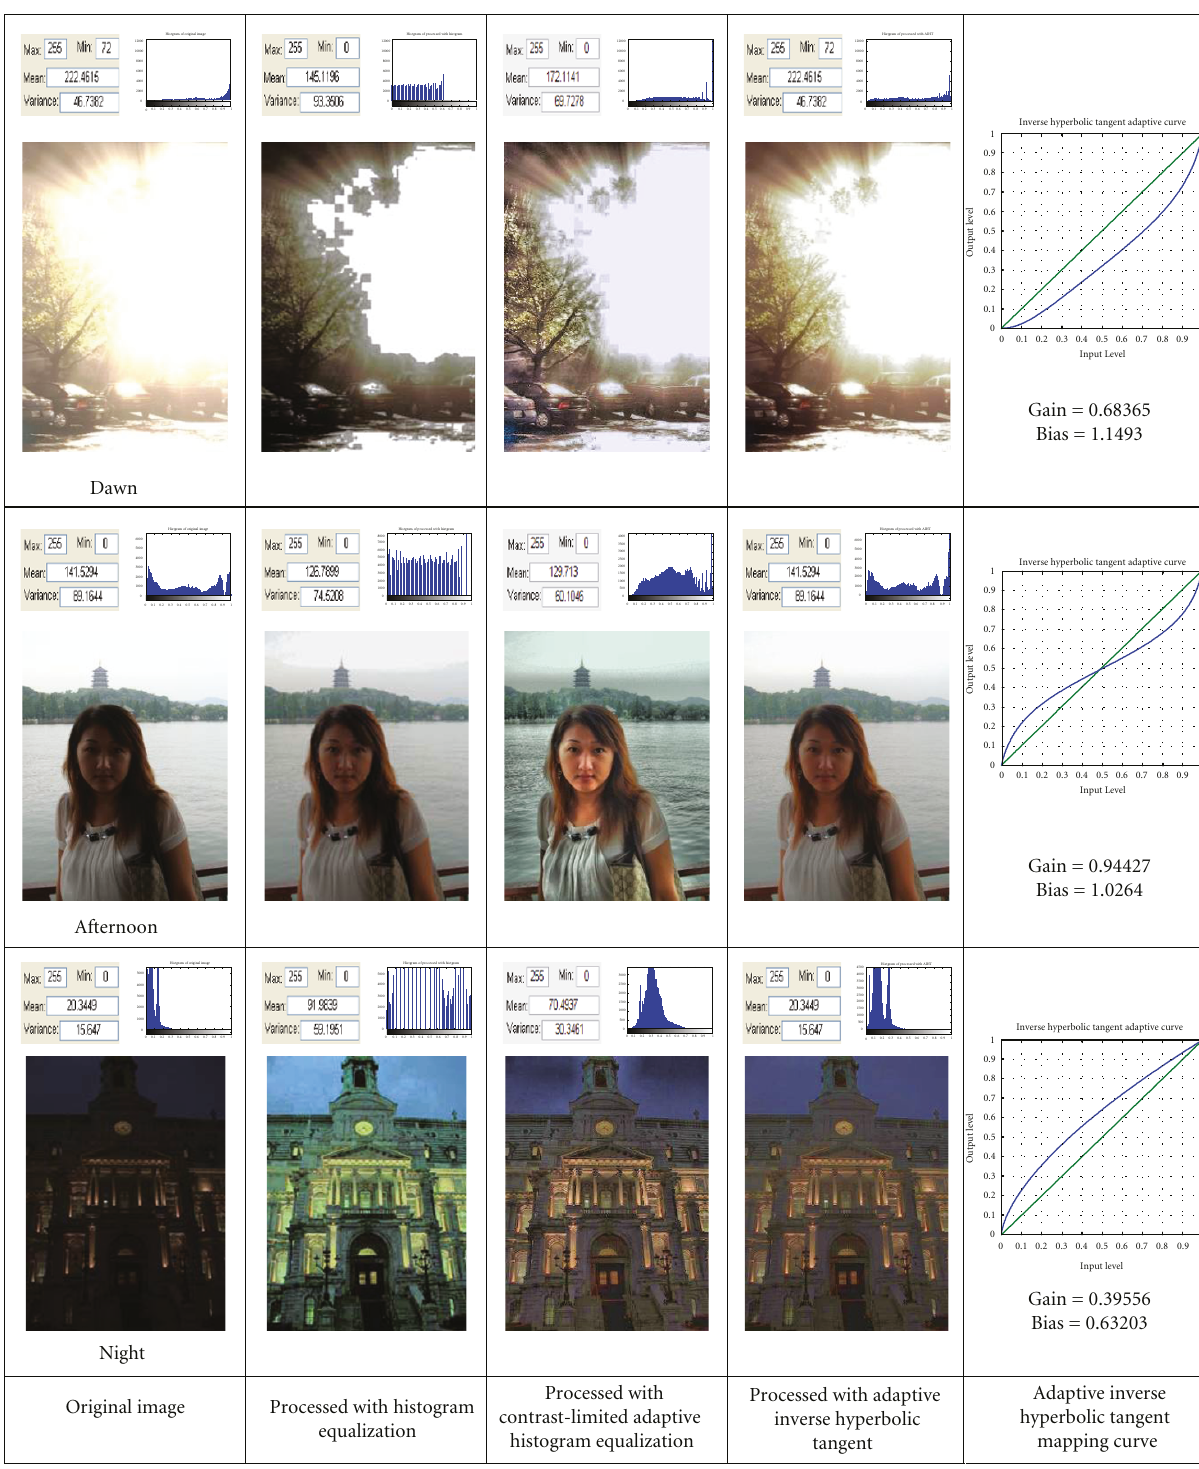
Figure 16: Various types of bad contrast images illustrating the di ff erence between contrast enhancement by histogram equalization, contrast limited adaptive histogram equalization, and our method (outdoor